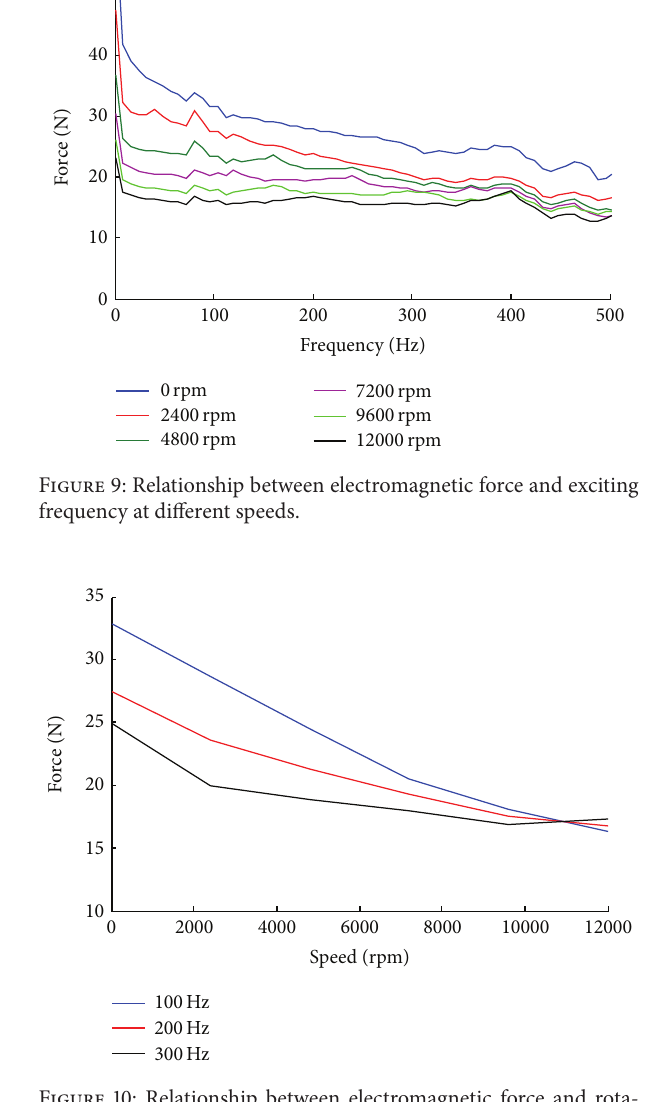
Figure 10: Relationship between electromagnetic force and rota- tional